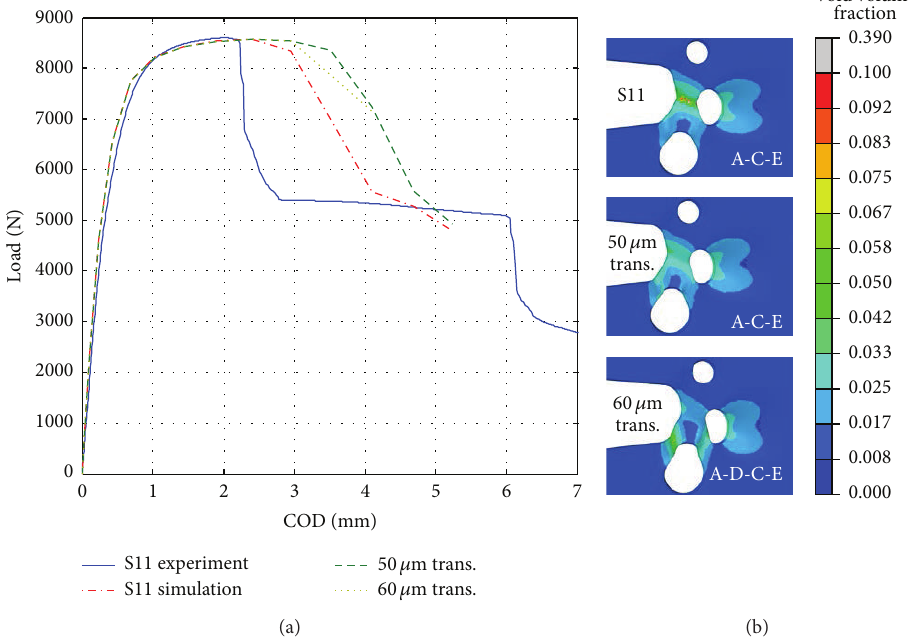
Figure 7: Experimental S11 load versus COD profile, simulated S11 load versus COD profile, simulated S11 with hole C translated down 50 𝜇 m load versus COD profile, and simulated S11 with hole C translated down 60 𝜇 m load versus COD profile, (a). The contours of void volume fraction were taken at load = 5,528 N, 7,239 N, and 7,140 N for S11, S11 w/50 𝜇 m translation, and S11 w/60 𝜇 m translation, respectively, (b).